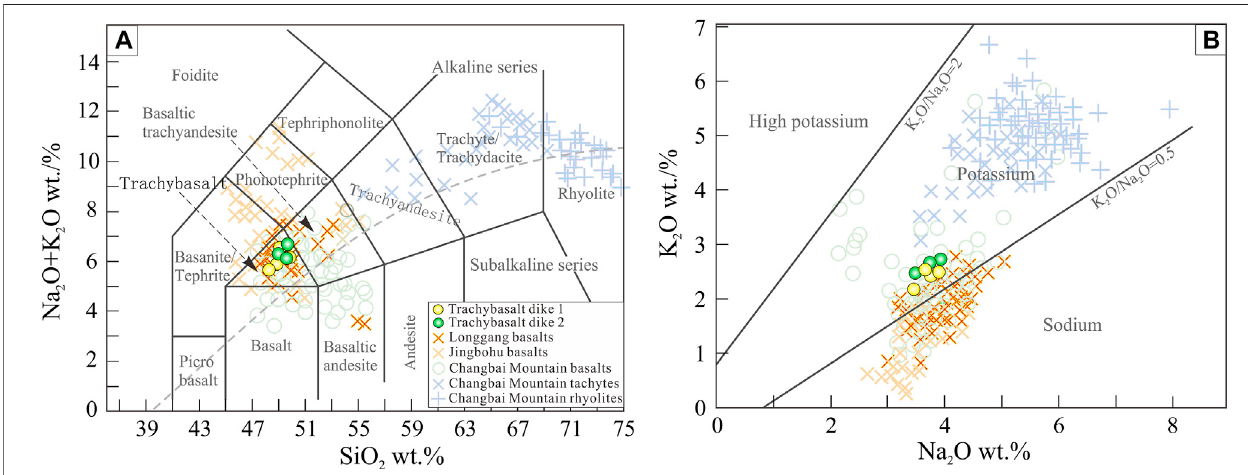
FIGURE 6 | (A) TAS (Le Maitre, 1989) and (B) K 2 O vs. Na 2 O diagrams of Middlemost (1994) showing the classi fi cation of the trachybasaltic dikes. Other data are from Wei (2014), Ma et al. (2015), Lei et al. (2020), Andreeva et al. (2014), Liu et al. (2015), and Zhang et al. (2015).